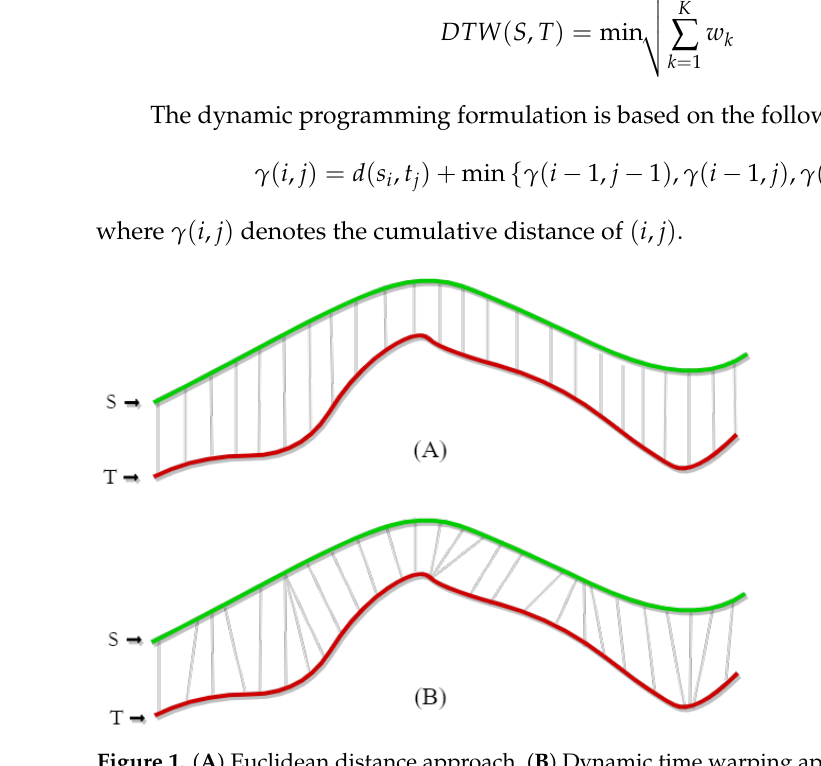
Figure 1. ( A ) Euclidean distance approach, ( B ) Dynamic time warping approach.